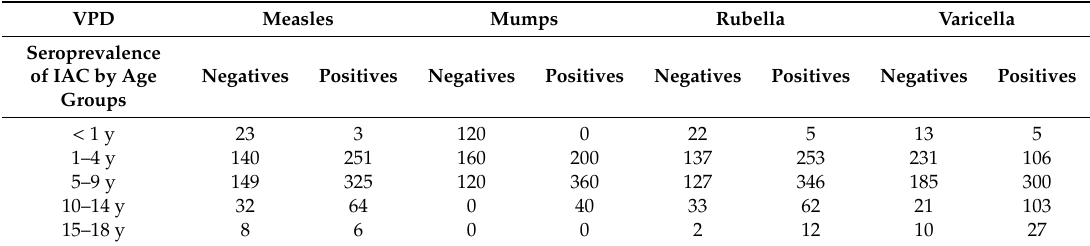
Table 6. Seroprevalence of the internationally adopted children (IAC) enrolled at the Meyer Children’s University Hospital and referred to a hypothetical population of 1000 IAC. VPD Measles Mumps Rubella